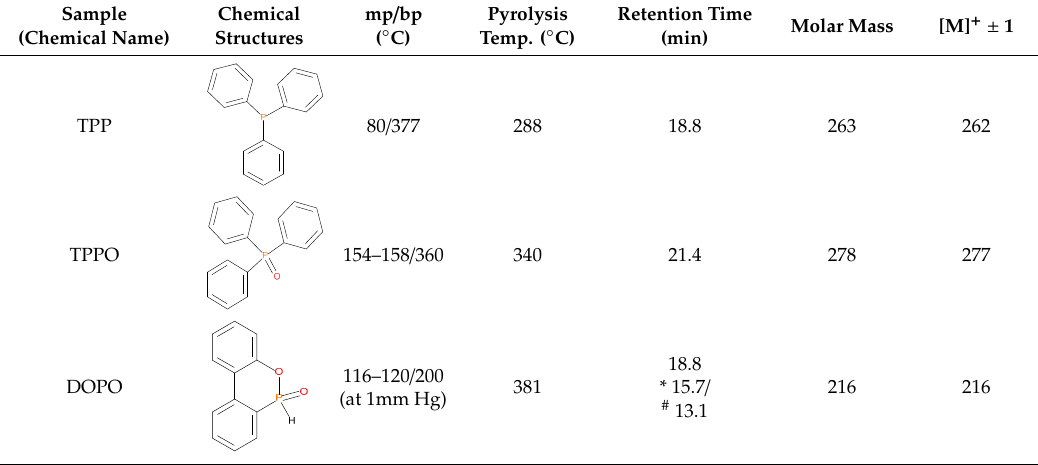
Table 5. Retention times and fragmentation features of the various solid additives.